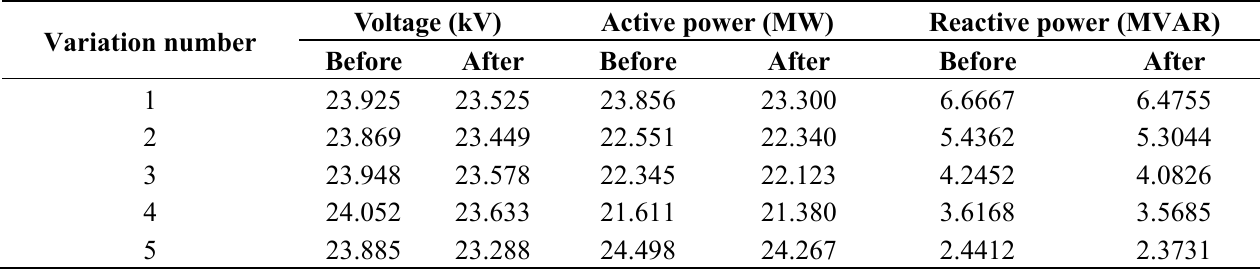
Table 3. Korean EMS data for the 344th transformer bank on winter evenings